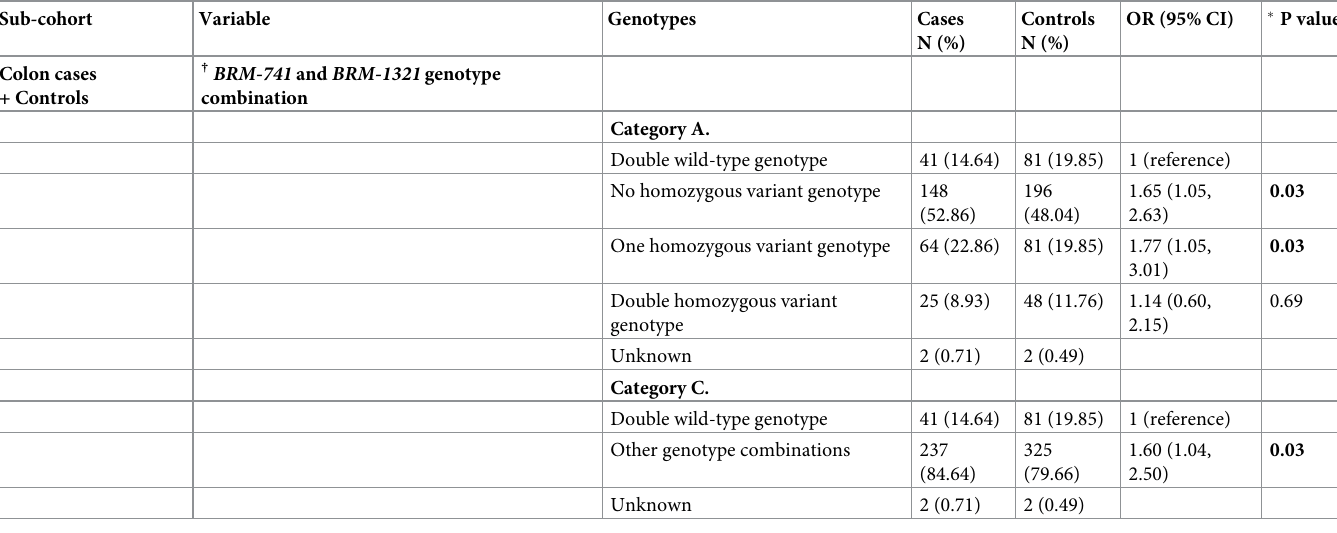
BRM codes for one of the two ATPase subunits of the SWI/SNF complex [12]. Two indel polymorphisms in the promoter region of BRM , BRM -741 and BRM -1321, have been shown to be associated with down-regulation of this gene [21], and therefore may affect the function of the SWI/SNF complex and cellular processes regulated by it. Some of these cellular Table 3. Associations between BRM promoter indels and colon cancer